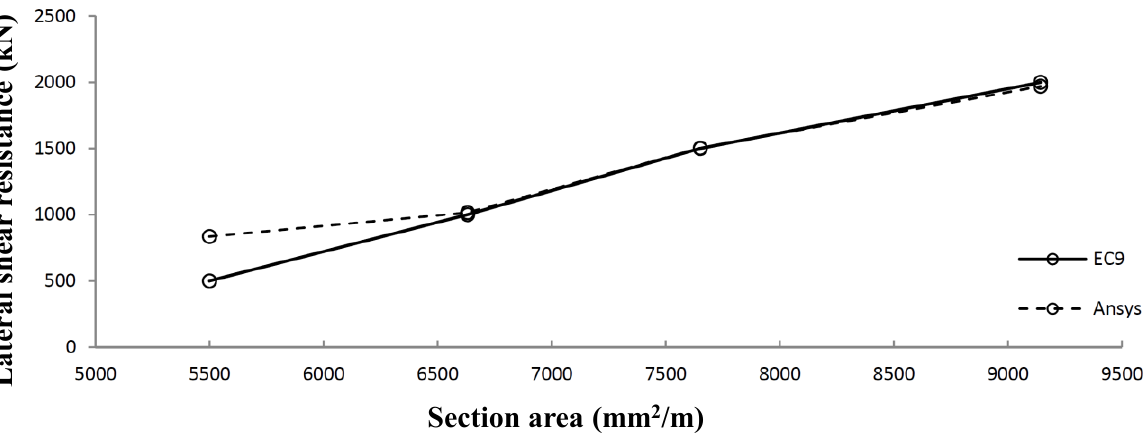
Figure 26. Comparison of shear panels optimized according to Eurocode 9 (EC9) versus